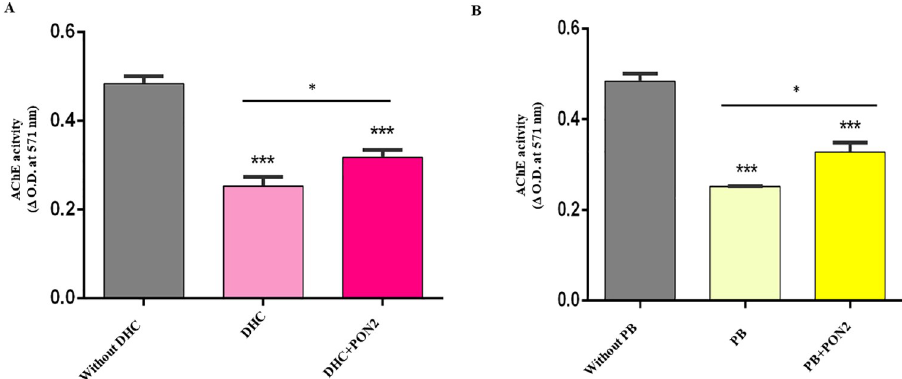
Fig 4. Comparison of AChE activity in the presence of inhibitors and enzymes. A. DHC, in the presence and absence of HuPON2, B. PB, in the presence and absence of HuPON2. Inhibition is shown for AChE activity in the absence of inhibitors and